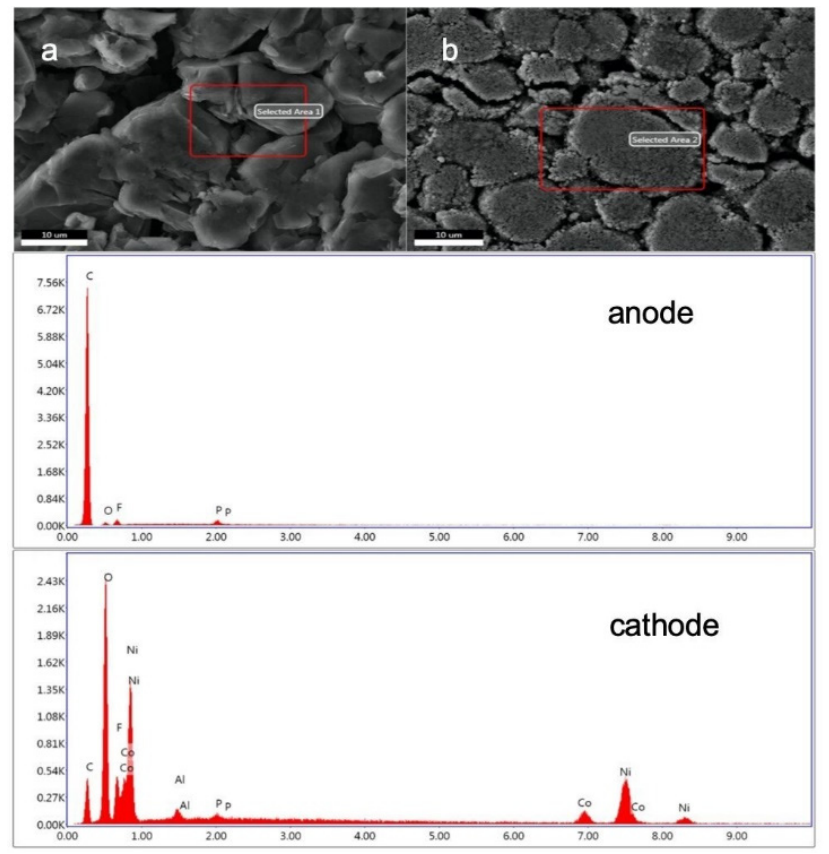
Figure 11. SEM-EDS analysis (5000×) of the new cell electrodes ( a ) anode (Area 1) ( b ) cathode (Area 2).